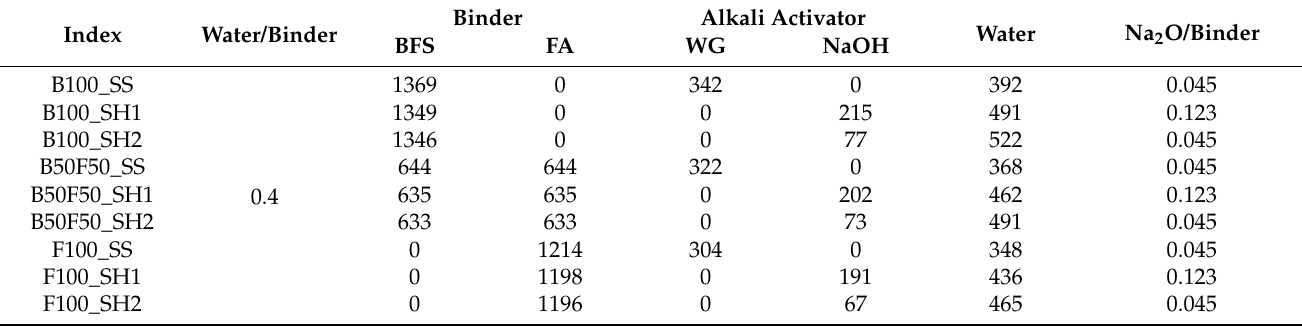
Table 3. Preparation of Paste Specimens (g/L).